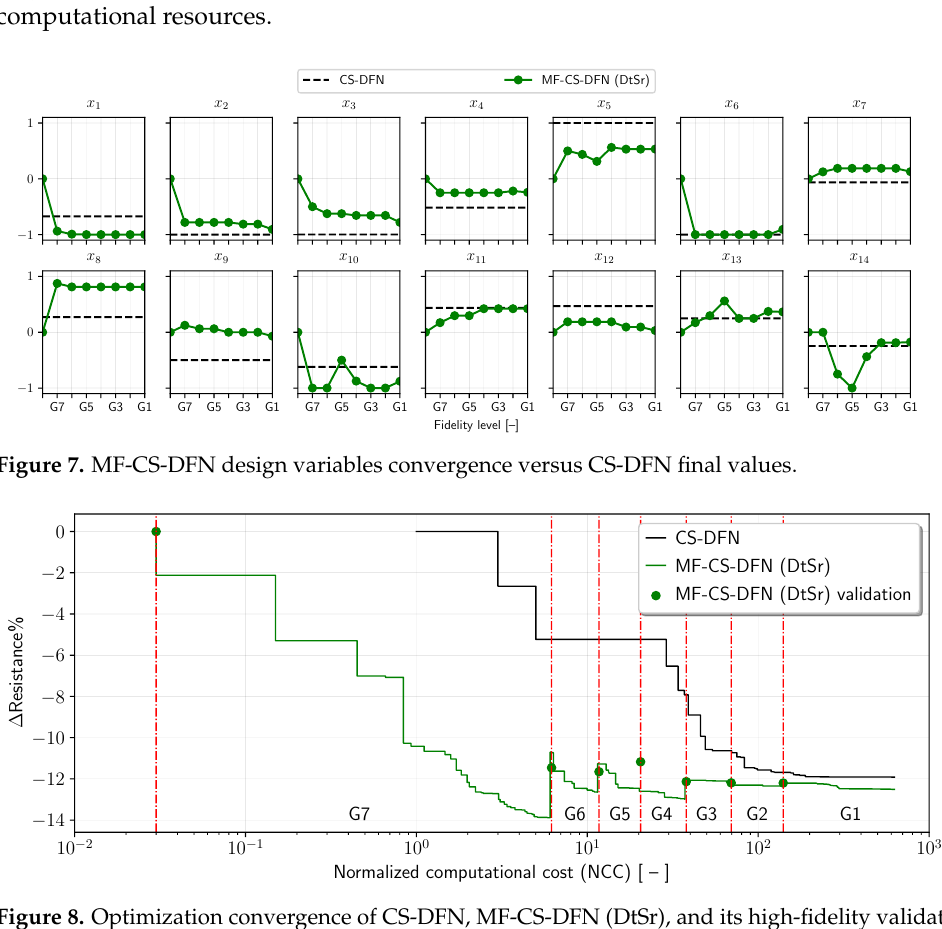
Figure 8. Optimization convergence of CS-DFN, MF-CS-DFN (DtSr), and its high-fidelity validation. Vertical dashed lines denote the fidelity change.